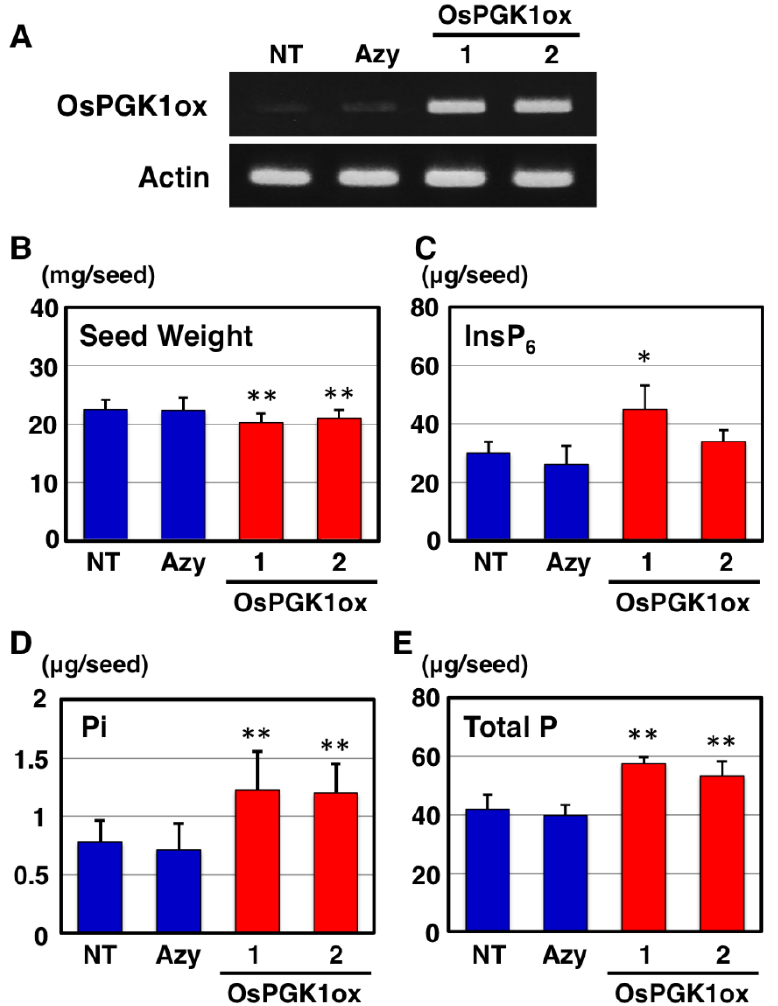
Figure 3. Gene expression and seed phenotype of OsPGK1ox transgenic plants. ( A ) Semi- quantitative RT-PCR analysis of the expression of OsPGK1 . Total RNA was extracted from flowers of non-transformants (NT), azygous plants (Azy), and two independent OsPGK1ox lines (1 and 2) just before flowering. Actin was used as a reference; ( B ) Seed weights ( n = 20); ( C ) InsP 6 content was determined by ion chromatography ( n = 4); ( D ) Inorganic phosphate content was measured by colorimetric assay using molybdate staining ( n = 10); ( E ) Total P content was measured by ICP-OES analysis ( n = 6). Each value ( B to E ) represents the mean ± SD. * and ** indicate p < 0.05 and p < 0.01,